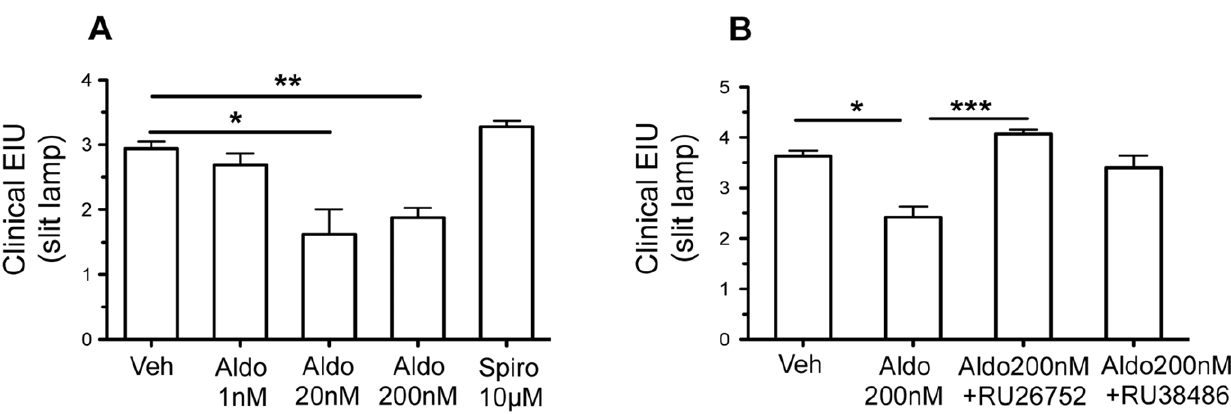
Figure 2. Effects of intravitreal injection of aldosterone or spironolactone on clinical EIU. Clinical scores of the severity of EIU were determined 24 hours after induction of EIU. Steroids were injected IVT in each eye, simultaneously to footpad LPS injection; 24 hours later, both eyes were evaluated, and scores of each eye were gathered as the clinical score of the animal. A: Intravitreal injection (IVT) of aldosterone (aldo; 1, 20 or 200 nM) or spironolactone (spiro; 10 m m): aldosterone (20–200 nM) induced a significant reduction of the clinical severity of EIU, compared to vehicle (Veh) IVT. Spironolactone did not modify the severity of EIU. Data are mean 6 SEM; n=8 rats per condition. B: Intravitreal injection of aldosterone (200 nM) alone or associated with the MR antagonist RU26752 (20 m M) or with the GR antagonist RU38486 (20 m M): benefit of aldosterone injection was confirmed, which was blunted in the presence of RU26752. There was no statistical difference between aldosterone + RU38486 IVT and vehicle injection or aldosterone IVT. Data are mean 6 SEM; n=10 rats per condition; *p , 0.05, **p , 0.01, ***p ,